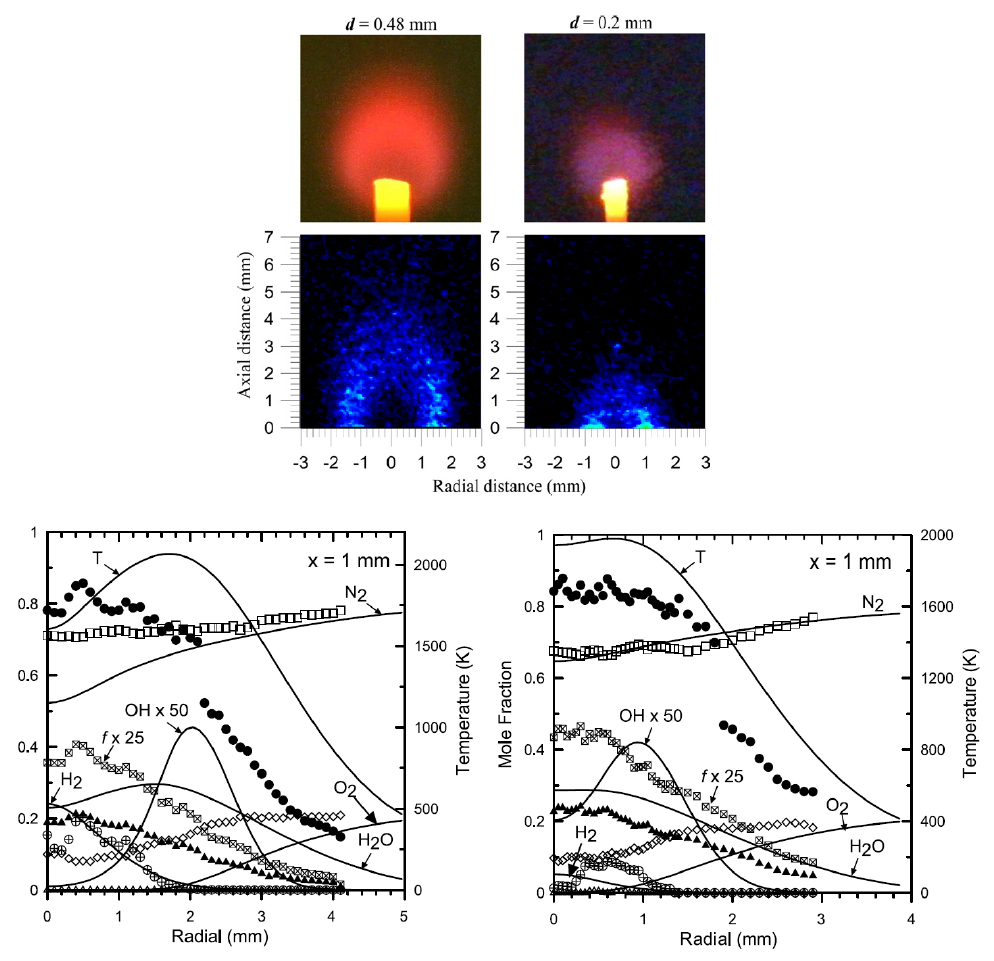
Figure 3. Experimental and numerical study of hydrogen micro-diffusion flame for different tube diameters by Cheng et al. [12]. Top : Photographs and single-pulse LIPF-OH (Laser Induced Predissociative Fluorescence - OH radical) (a pre-dissociation fluorescence technique to collect densities of OH radicals) images of the microscale hydrogen diffusion flames with tube diameters of 0.2 and 0.48 mm; Bottom : Comparison of measured mean temperature, major species, and OH mole fraction with calculated radial profile for d = 0.48 mm ( bottom-left ) and 0.2 mm ( bottom-right ) flame at x = 1